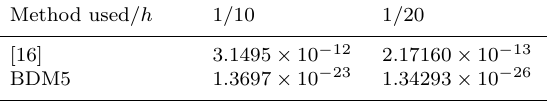
Table 6. Comparison of maximum absolute errors (MAE) on Example 2.